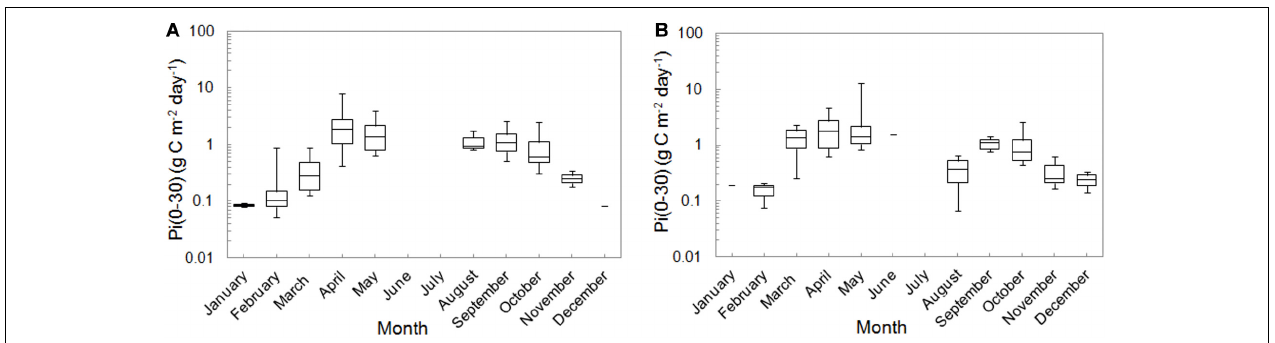
was usually recognized as the main reason of the differences in the absolute values of PP determined in situ . In our case, however, the discrepancies are not only due to natural causes.